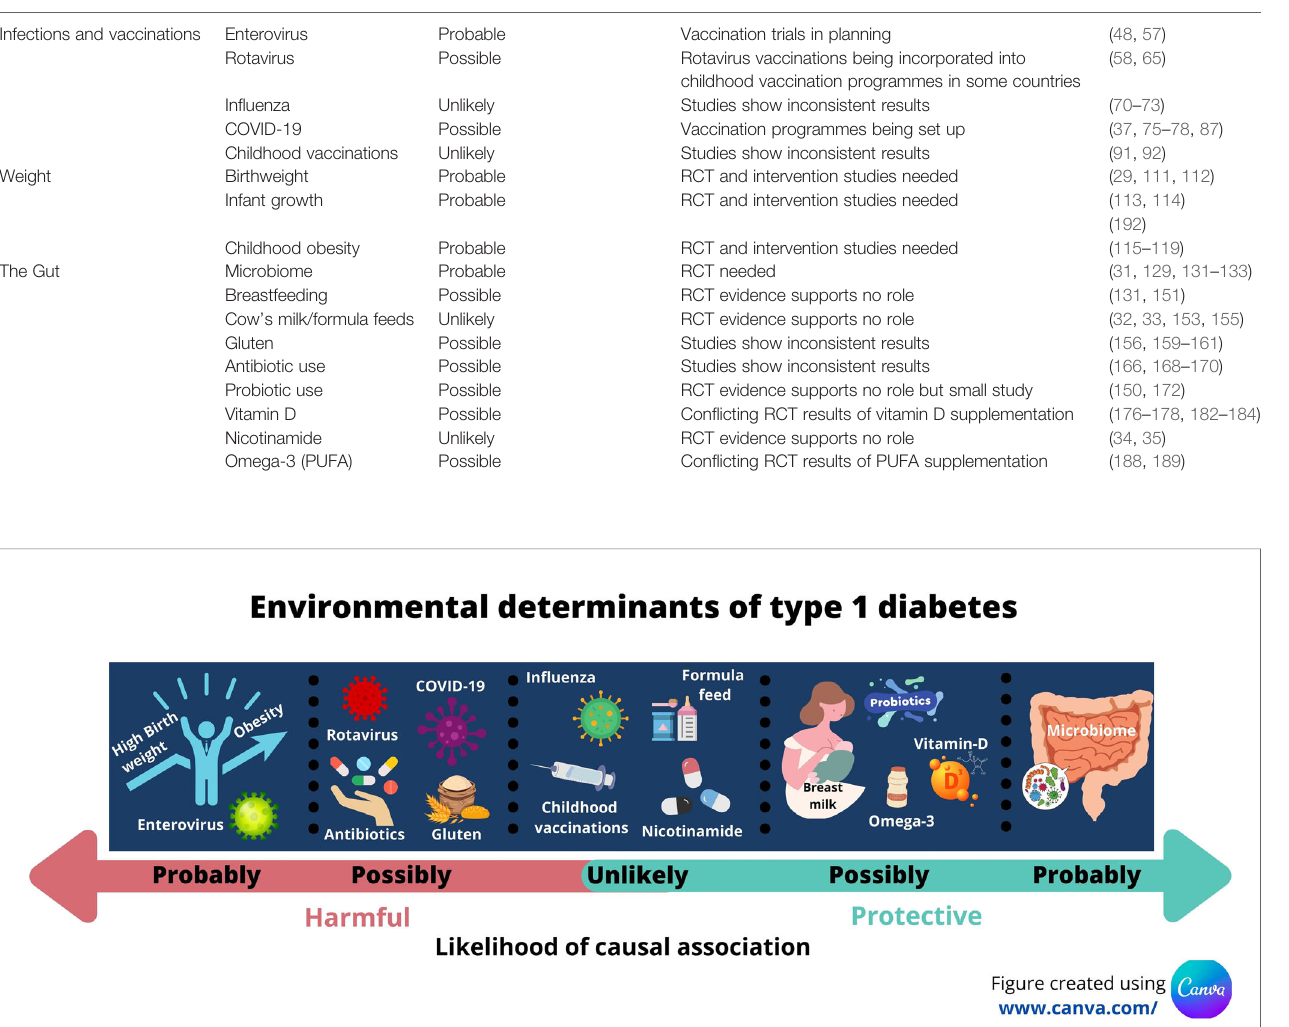
FIGURE 1 | Infographic illustrating the key environmental determinants of type 1 diabetes and their likelihood of contributing to causality.